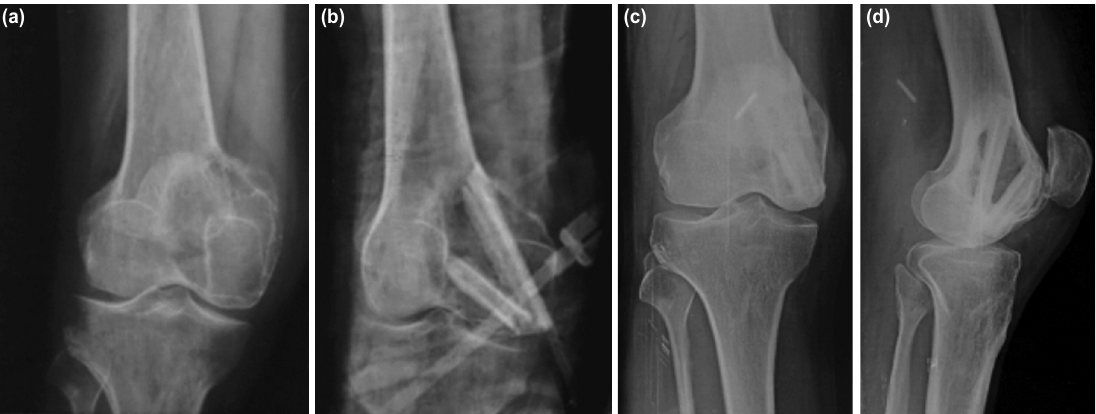
(a) Giant cell tumour of the medial femoral condyle in a 38-year-old. (b) Immediate post-operation radiograph shows cavity Fig. 4: supported with two struts. (c,d) Good hypertrophy and incorporation of the graft at two years post-operation.